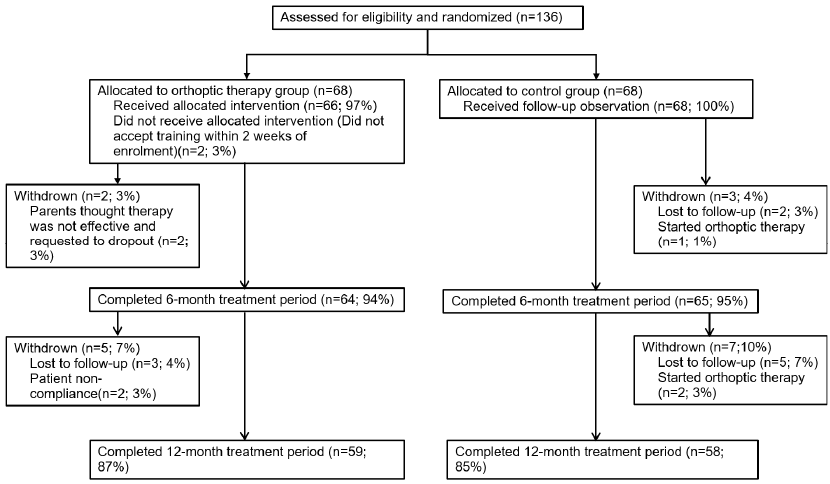
Figure 1. Flowchart showing the progress of participants through our current study.